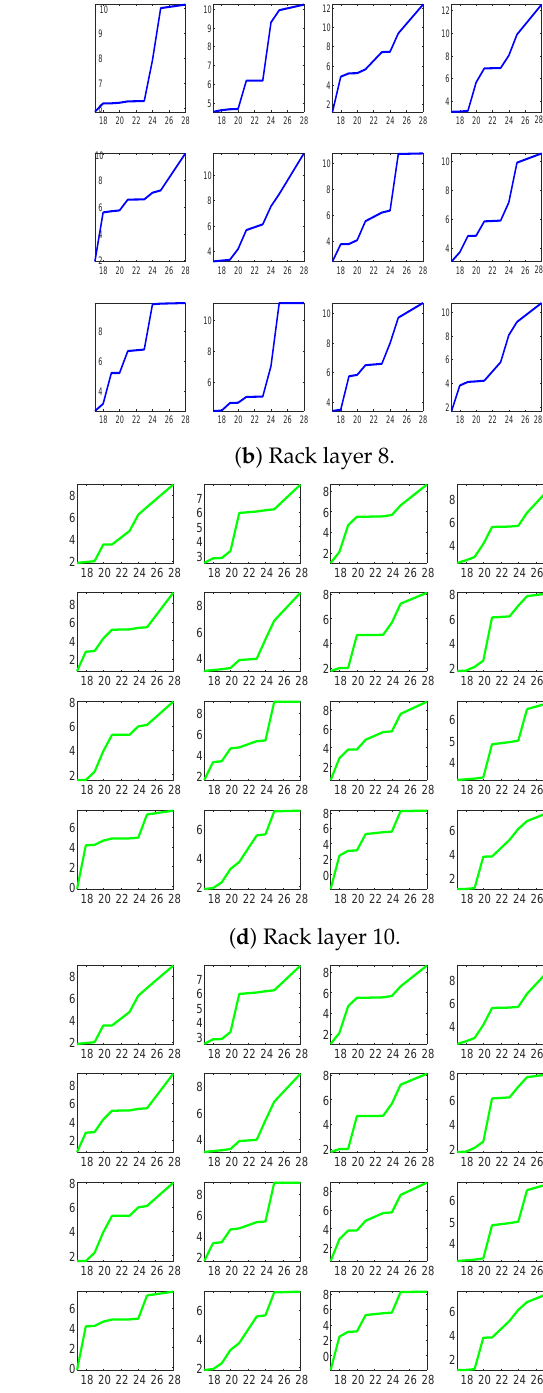
( c ) Rack layer 9. ( d ) Rack layer 10.